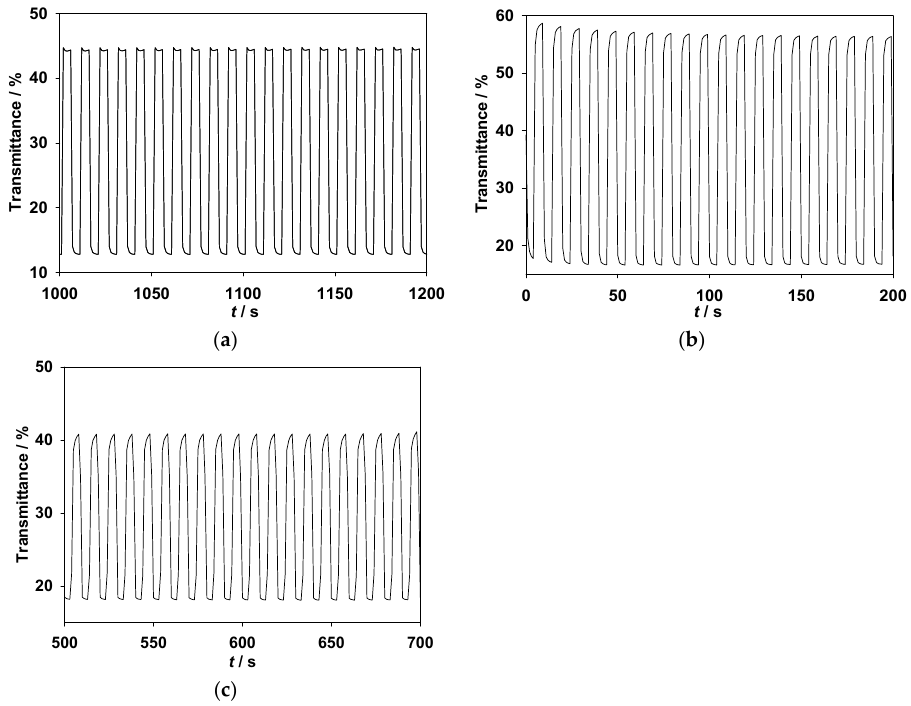
Figure 9. In situ transmittance of ( a ) PMPS/PProDOT-Et 2 ECD at 590 nm as a function of time, the ECD was stepped by repeated potential between − 0.4 and +1.0 V; ( b ) PMPO/PProDOT-Et 2 ECD at 626 nm, the ECD was stepped by repeated potential between − 0.4 and 1.2 V; and ( c ) PANIL/PProDOT-Et 2 ECDs at 628 nm, the ECD was stepped by repeated potential between 0 and 1.2 V.